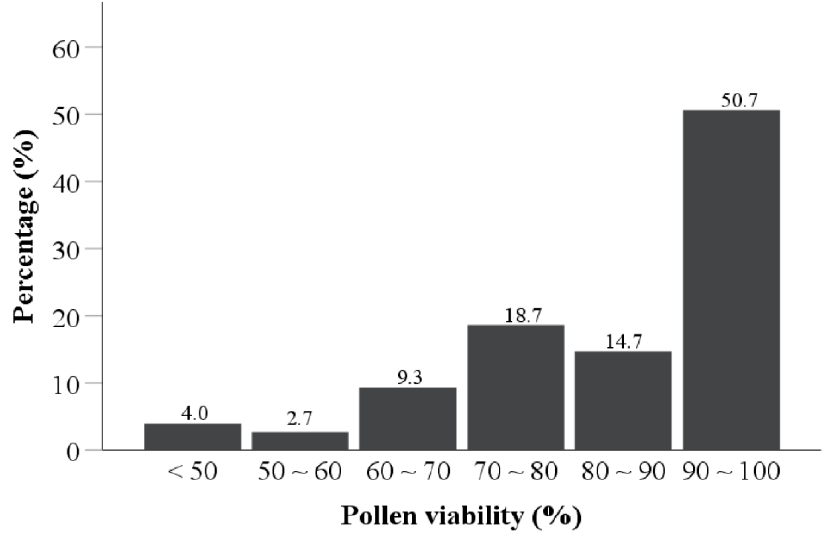
Figure 3. Pollen viability distribution for 75 tea varieties.